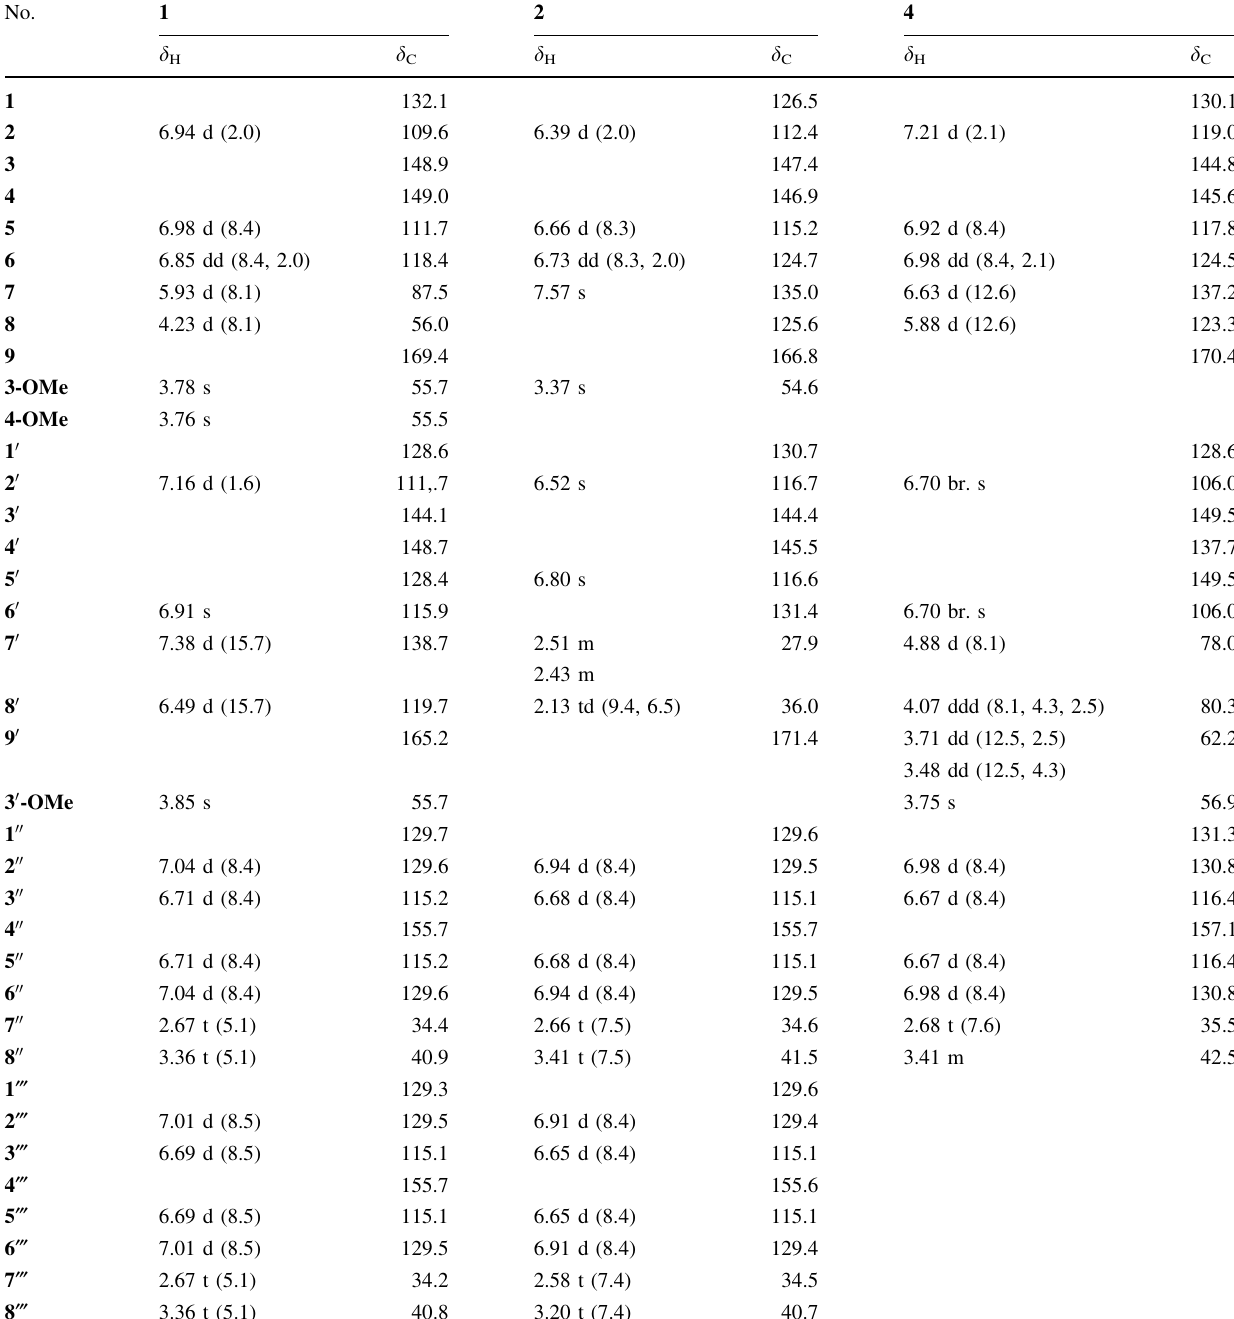
Table 1 1 H (600 MHz) and 13 C NMR (150 MHz) Data for compounds 1 , 2 in DMSO- d 6 and 4 in CD 3 OD ( d in ppm, J in